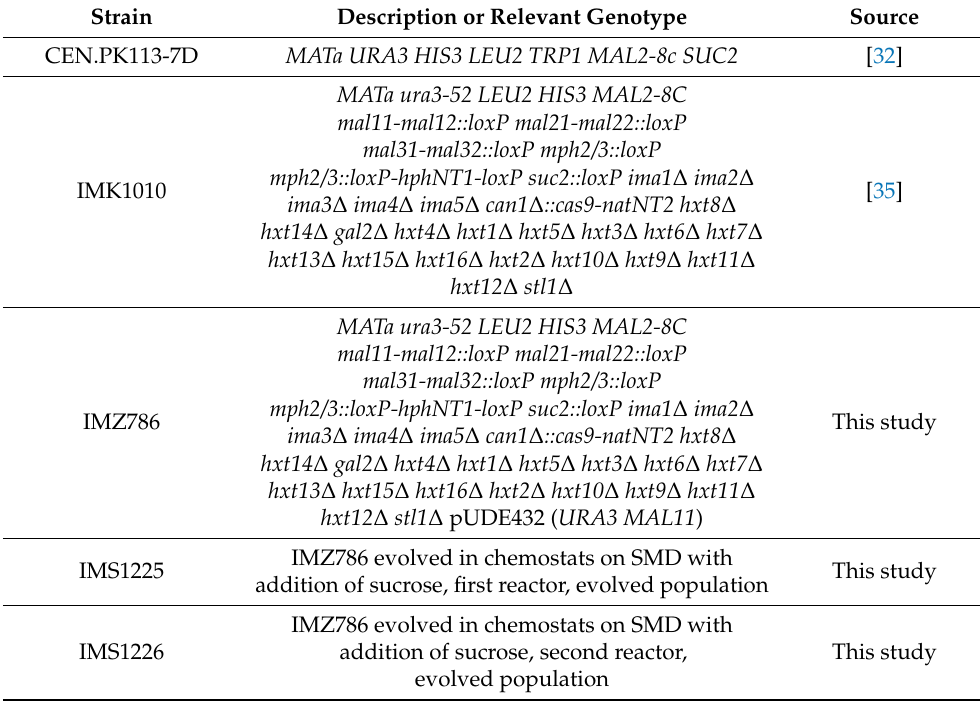
Table 1. S. cerevisiae strains used in this study. The prefix ‘pUDE’ signifies an episomal plasmid.